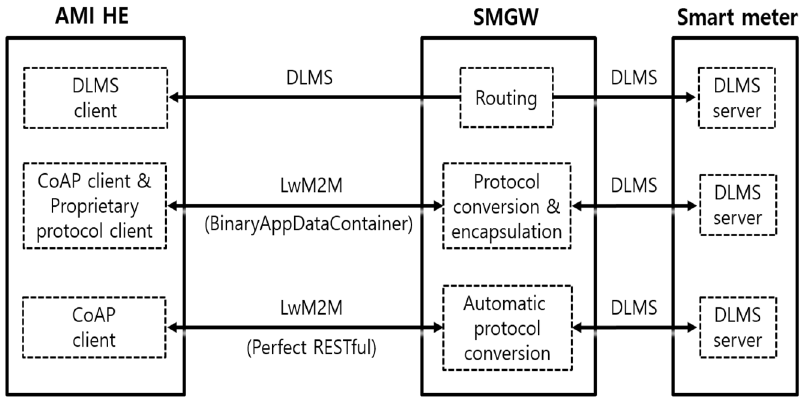
Figure 6. Three remote metering approaches to compare performance metrics.